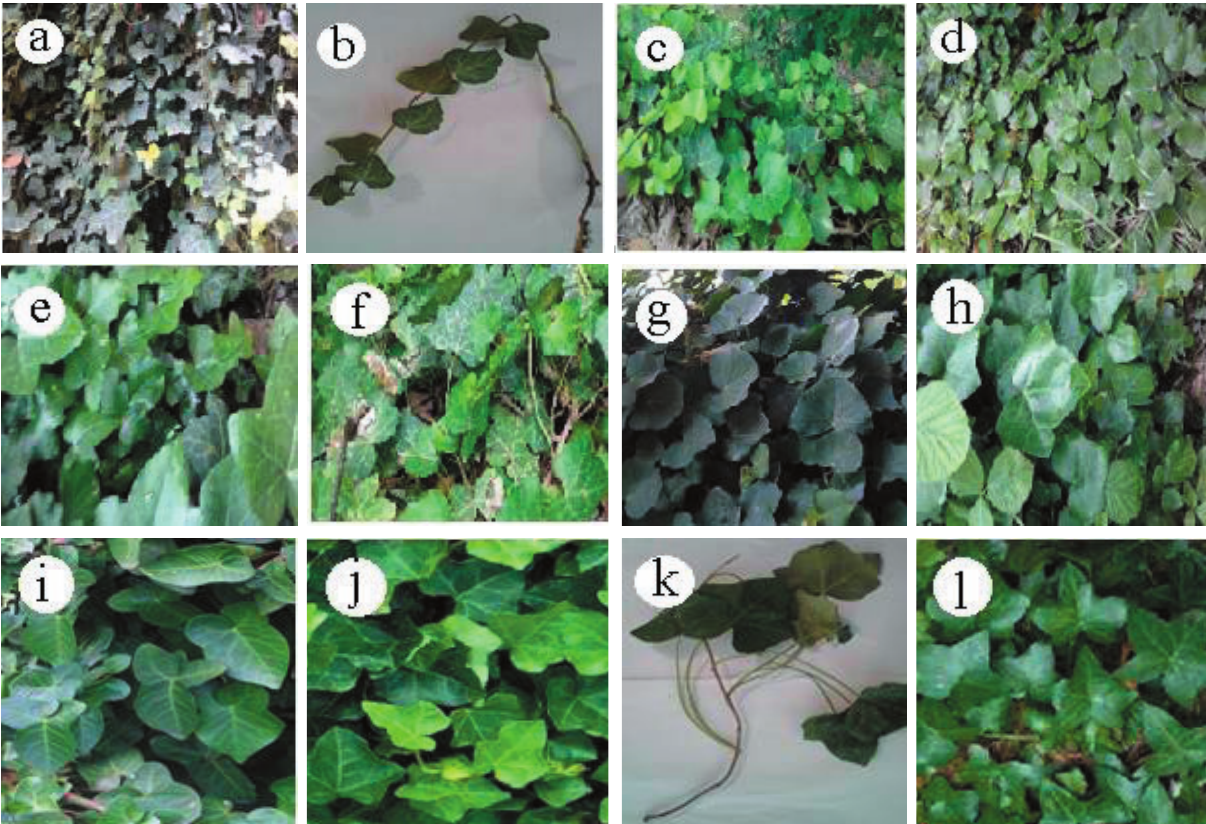
Figure 1. Images of Hedera species analysed in this study: a,b: H. helix, c: H. helix arborescence , d,e: H. hibetnica , f: H. hibernica arbores- cence , g,h: H. crebrescens, i: H. hibernica “Deltoiedea”, j, k: H. hibernica ” Variegata”, l: H. hibernica